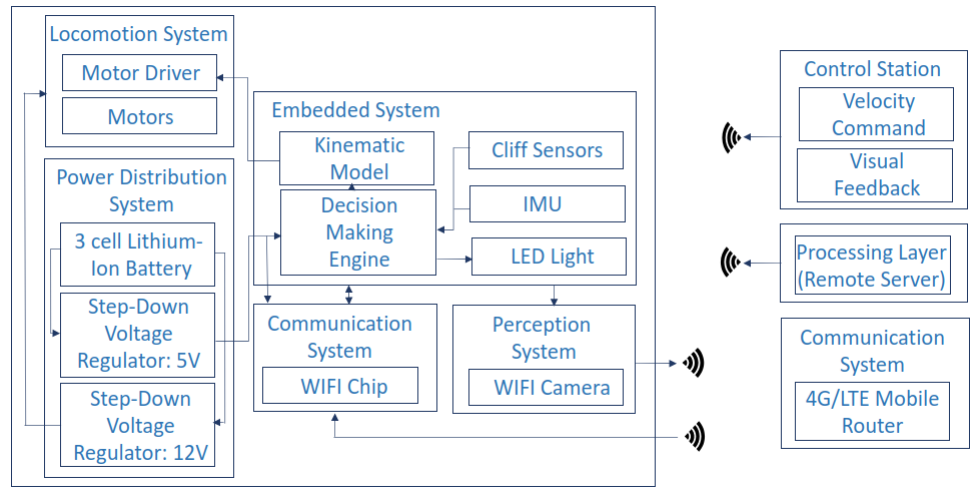
Figure 4. System architecture of the